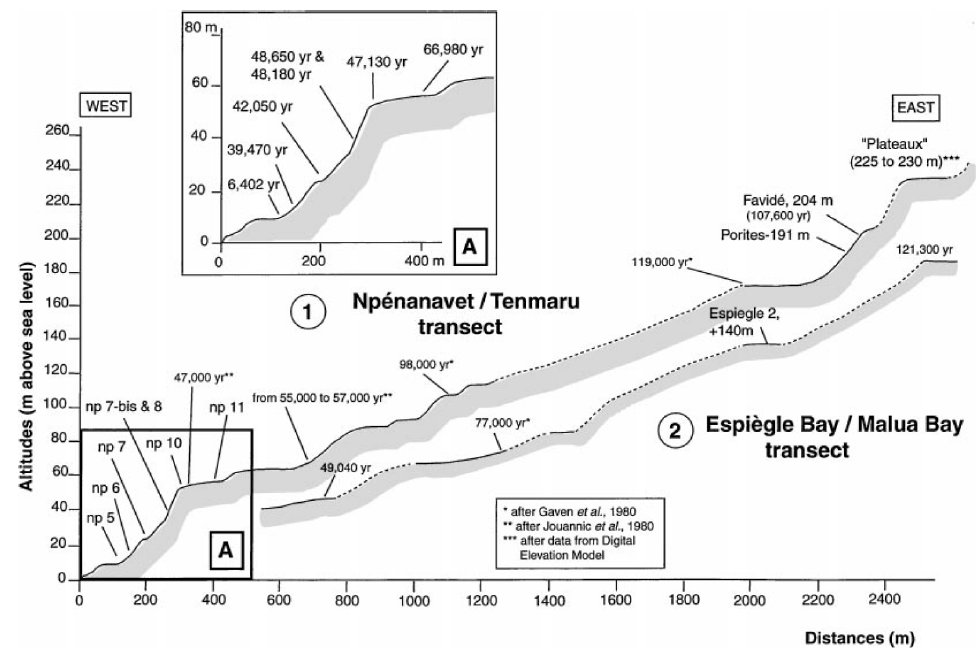
Figure 23. Profile showing the distribution of reef terraces on Malakula. Transect 1: Npénanavet–Tenmaru transect; transect 2: Espiègle Bay–Malua Bay transect (from Cabioch and Ayliffe, 2001).